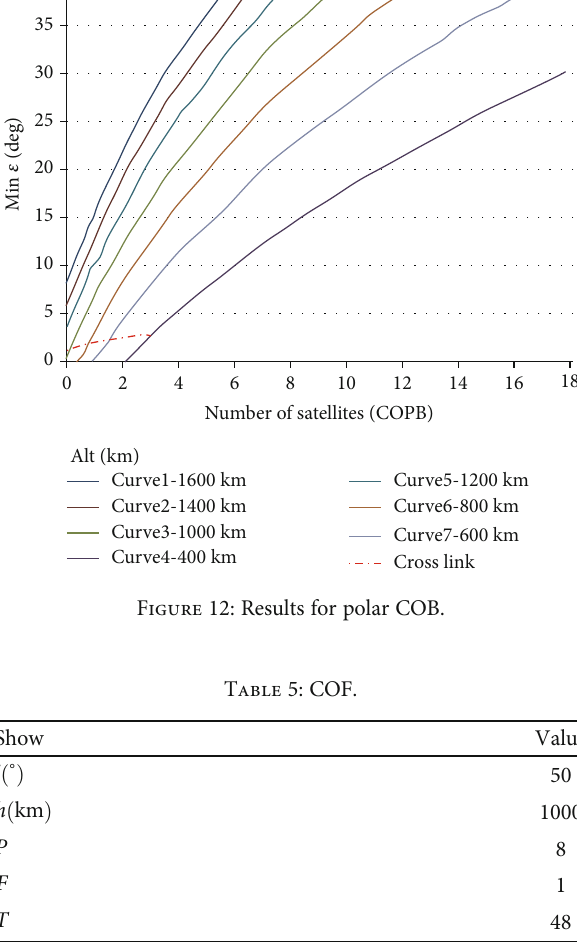
Figure 11: Results for COB.